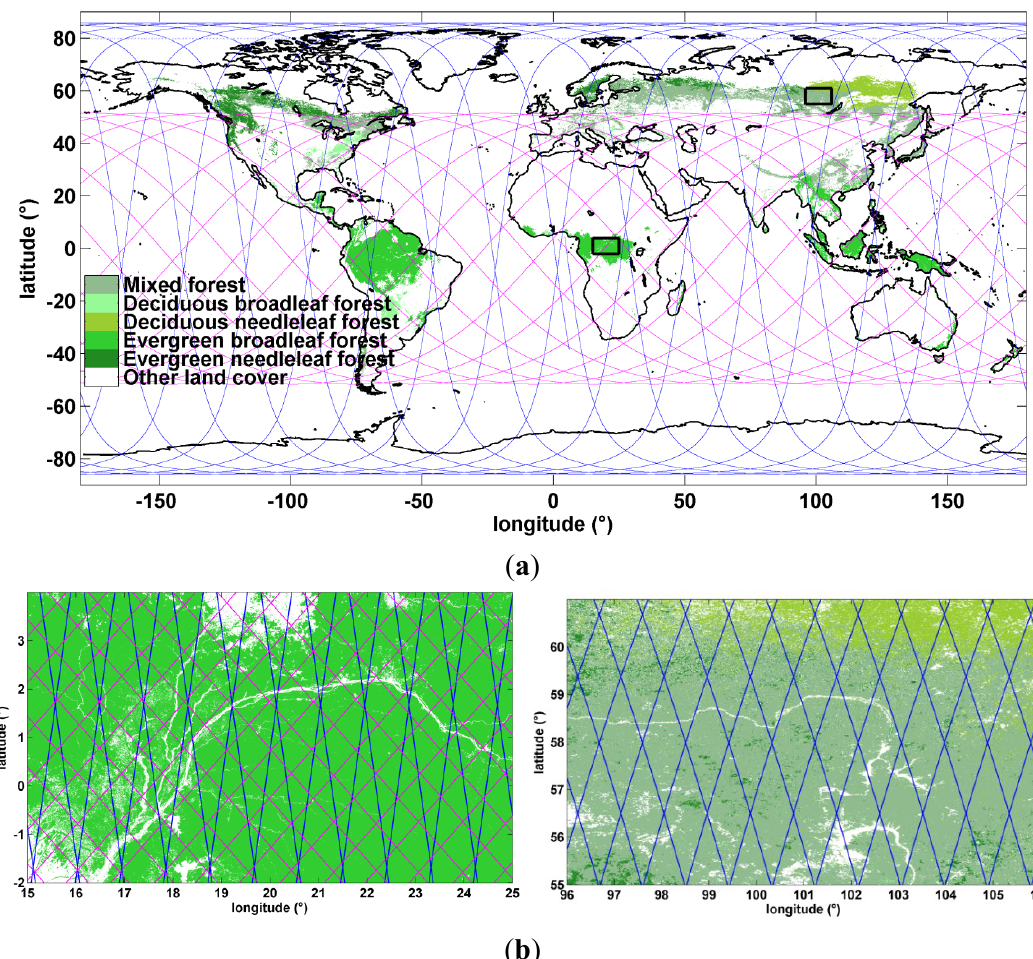
Figure 13. ( a ) Simulated orbits of ISS (in pink) and ICESat (in blue) of 1 day over the simplified land-cover map derived from MCD12C1 (MODIS) of 2011 with a spatial resolution of 0.05°; ( b ) Simulated orbits of 26 days over the Congo basin (Africa) zone ( left ) and lake Baïkal (Asia) zone ( right ), land-cover maps were derived from MCD12Q1 (MODIS) of 2011 with a spatial resolution of 500 m. The different green colors indicate five dominant forest types as named in ( a